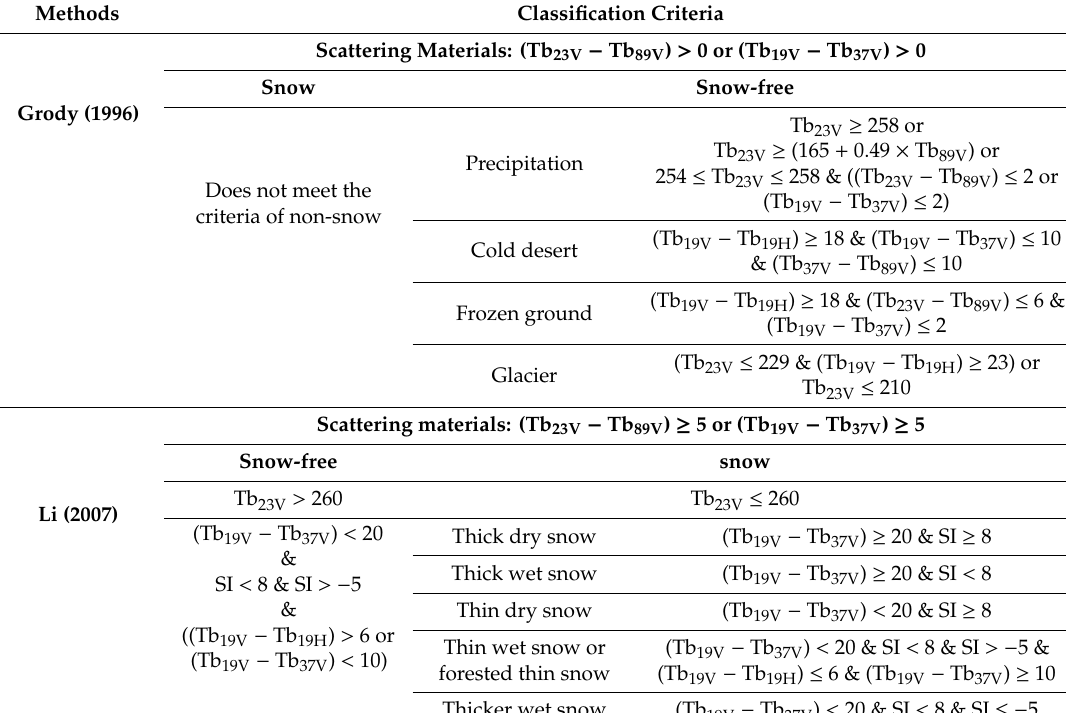
Table 3. Classification criteria of passive microwave (PMW) snow cover detection